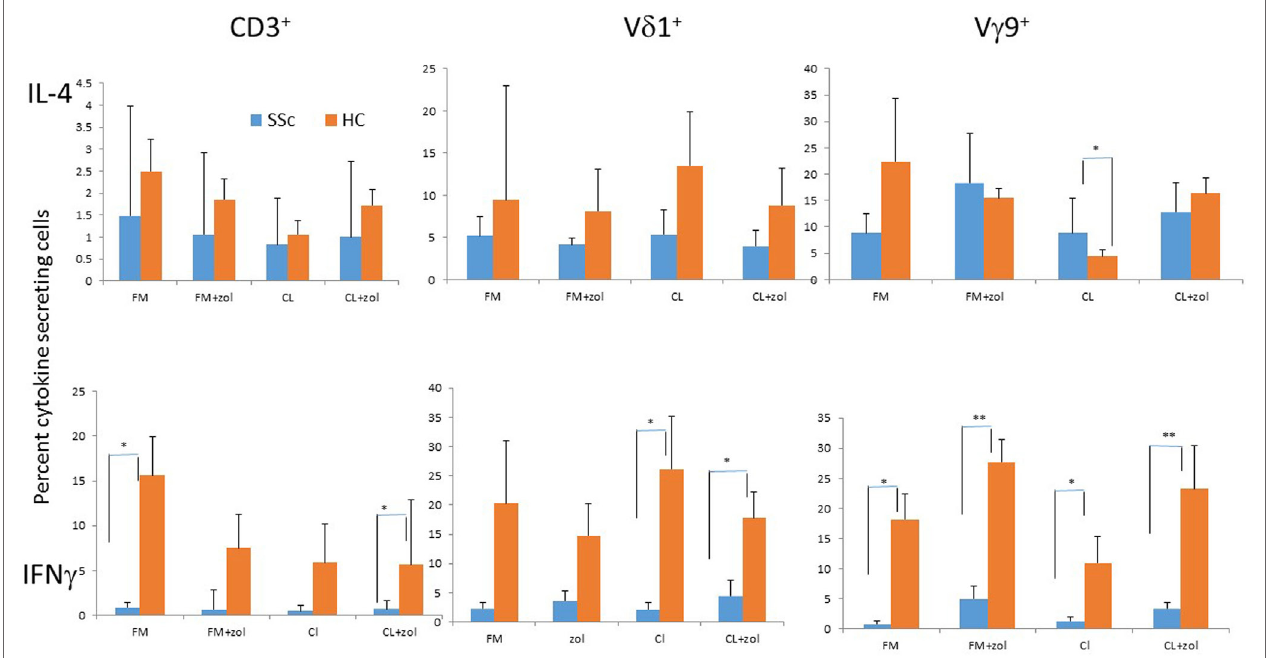
FigUre 6 | Cytokine production by systemic sclerosis (SSc) patients and healthy controls (HCs) T cells. Peripheral blood mononuclear cells from seven SSc patients (patients 13–19; Table 1 ) and five HC were cultured overnight in medium alone (FM), cardiolipin (CL), zoledronate (zol), or both (FM + zl or CL + zol). Subsequently, cell surface membranes were stained with monoclonal antibody (mAb) to CD3, V γ 9, or V δ 1, and cells were stained intracellularly with mAb to IL-4 (upper panel) or IFN γ . Bars indicate the mean ± 1 SEM of %cytokine + cells for the subsets as indicated. * p < 0.05 and ** p < 0.005 for comparison of adjacent SSc and HC mean values,